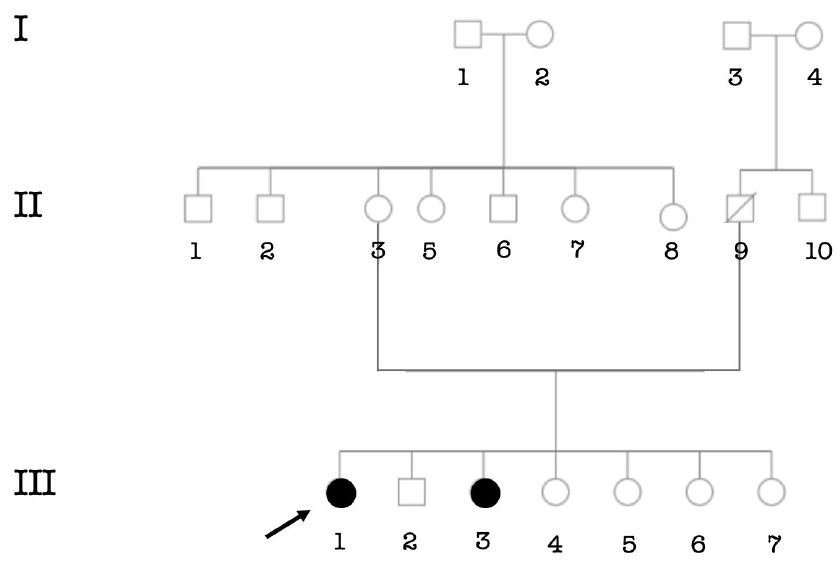
Figure 10. Pedigree showing two affected individuals from a non-consanguineous marriage. The arrow indicates the